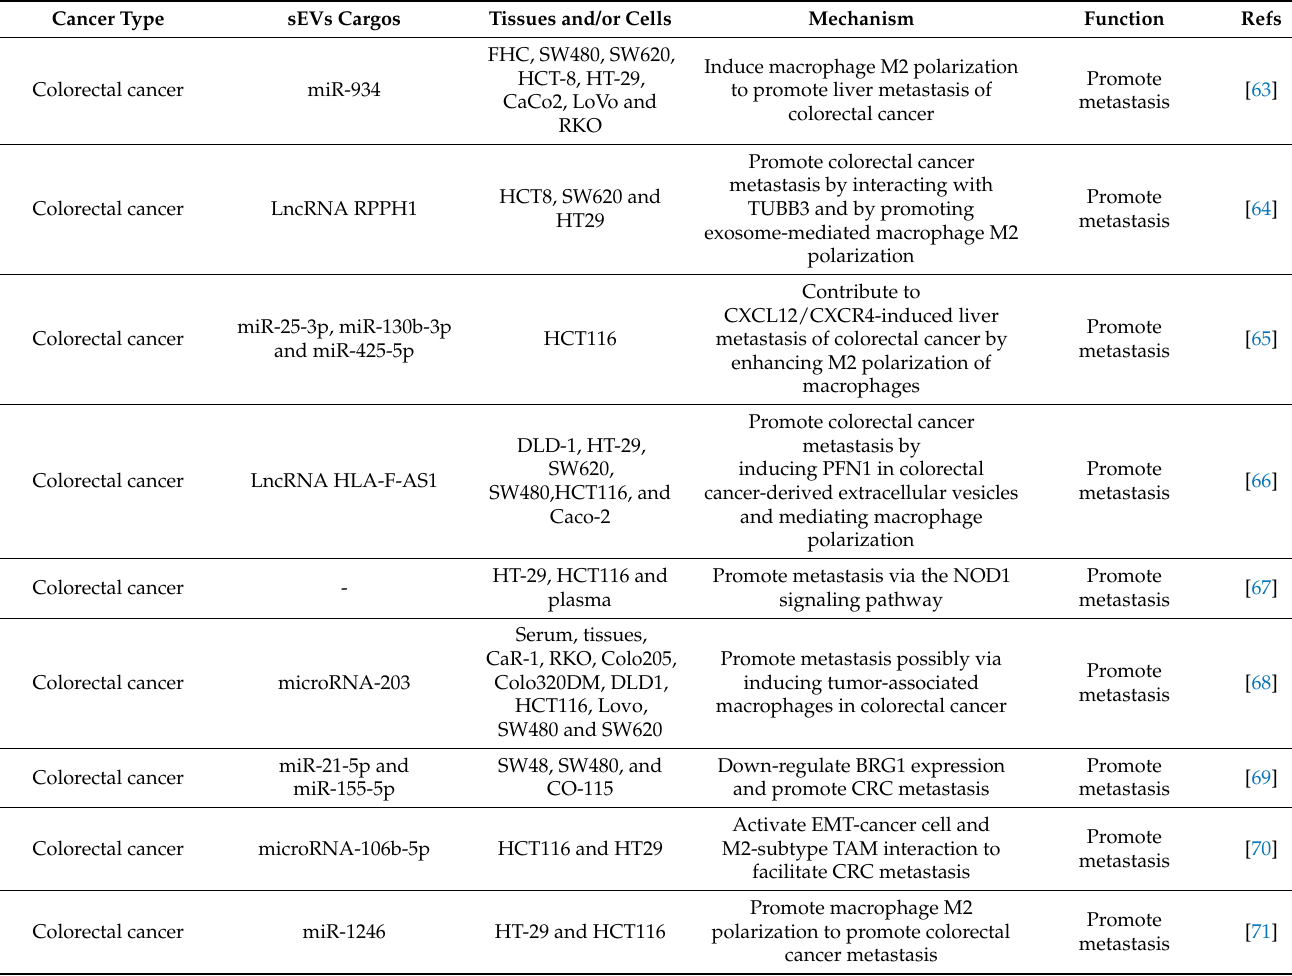
Table 3. sEVs promote macrophages to undergo M2 polarization affecting CRC